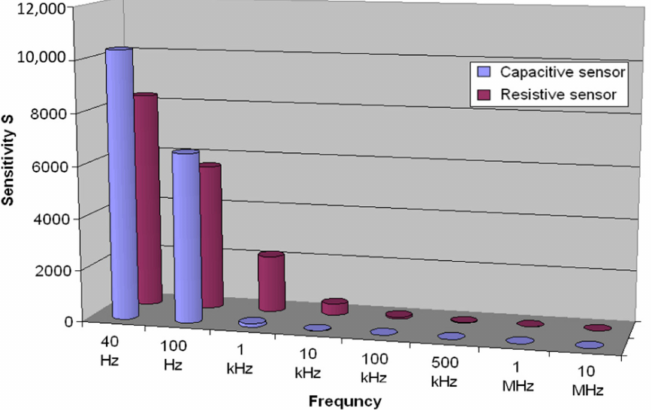
Figure 7. The sensitivity of both sensor regimes, capacitive and resistive, depending on the working frequency in the range of 0–98%